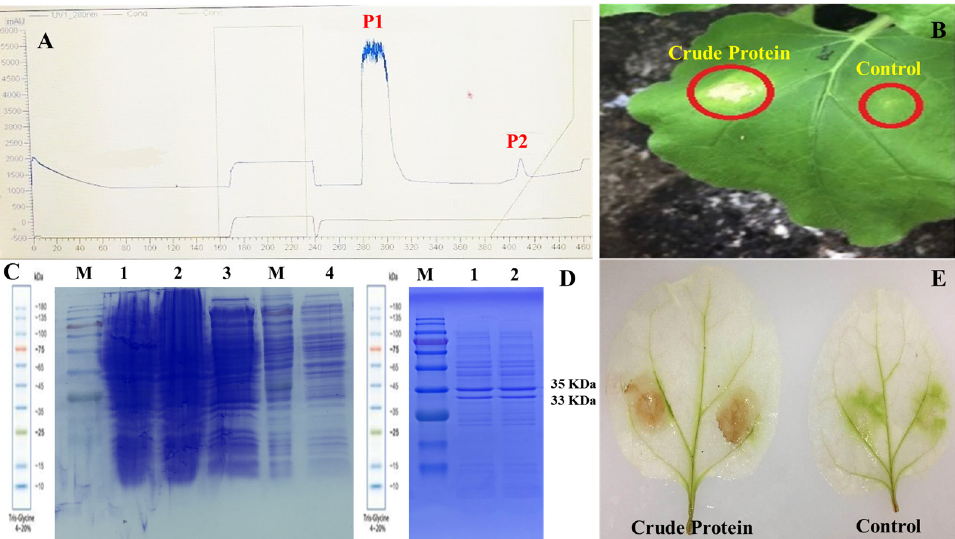
Figure 1. Crude protein purification from B. bassiana (ARSEF 2860). ( A ) Ion-exchange chromatography exhibited two peaks (1 and 2) of crude protein acquired from 80% ammonium sulfate precipitation and purified by the ÄKTA Explorer 10 protein purification system; ( B ) the necrosis induced by crude protein (0.063 μ M) in the leaves of N. tabacum observed at 24 h post treatment. In control treatment, the leaves of N. tabacum were treated with buffer (50 mM Tris-HCL, pH 8.0); ( C ) filtrate (lanes 1, 2 and 3) and proteins (lane 4) derived from B. bassiana precipitated on 12% SDS-PAGE using 80% ammonium sulfate. Lane M corresponds to molecular weight of protein markers; ( D ) B. bassiana- derived proteins purified through chromatography column resolved on 12% SDS-PAGE. Lane M corresponds to molecular weight of protein markers, shown in kilodaltons. ( E ) ROS burst in the cells of N. tabacum observed after crude protein treatment. Brown DAB blemished precipitates represent the ROS burst.